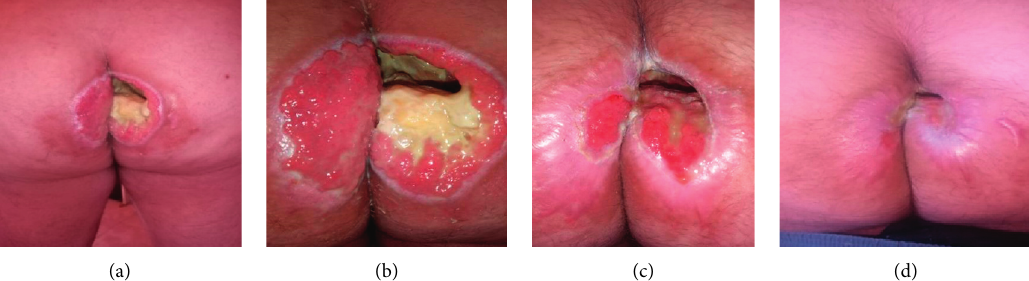
Figure 2: Wound progression with Curefini ® treatment. (a) Day 42: after 12 days of Curefini ® local treatment. (b) Day 60: after 30 days of Curefini ® . (c) Day 75: after 45 days of Curefini ® local treatment. (d) Follow-up after three